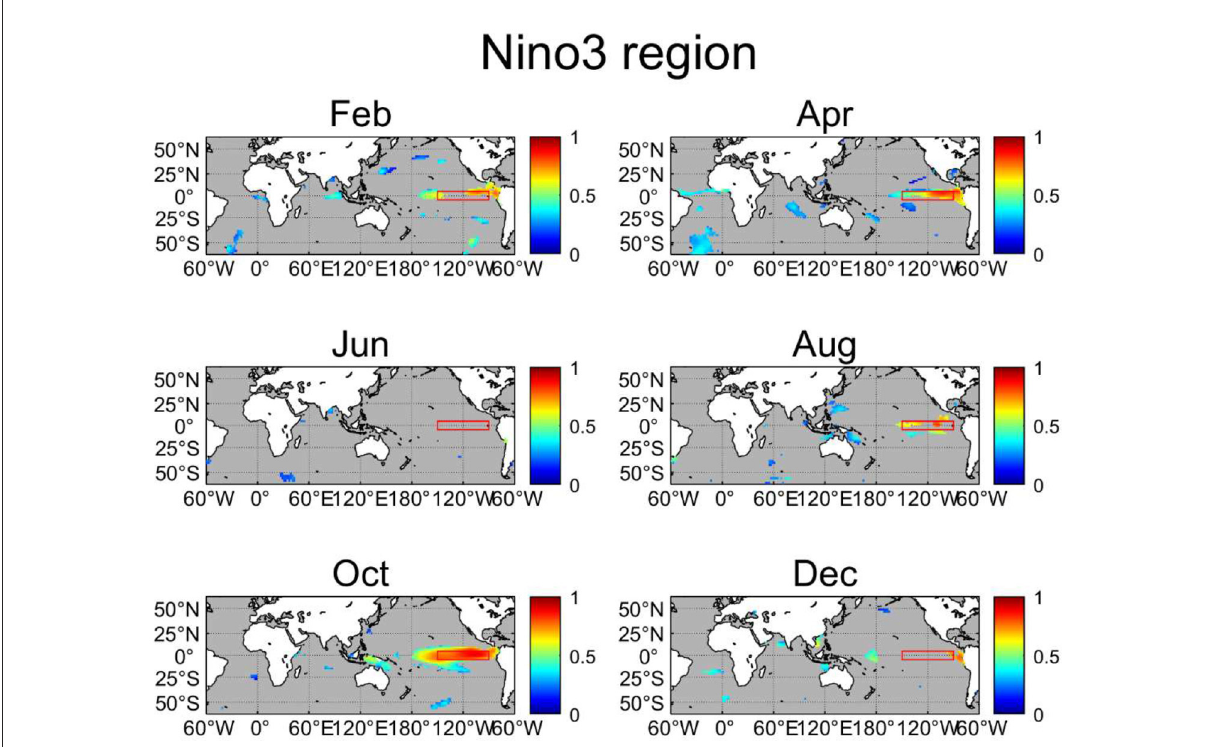
FIGURE8 NIFs from remote SST to local precipitation in the Niño-3 region (red box; 150–90 ◦ W, 5 ◦ N December. Gray grid cells signify that the NIF is not significant at the 90% confidence